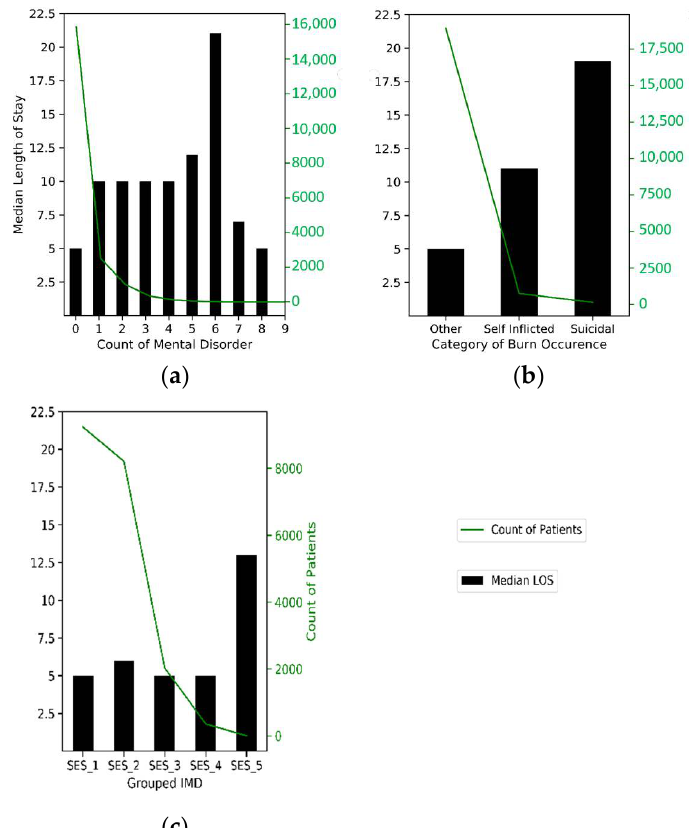
Figure 4. Patient profile by key variables of interest. ( a ) This shows varying median LOS by the number of pre-existing mental disorders. ( b ) This shows varying median LOS by category of burn grouped into two mental states and one other state (nonmental-state-related). ( c ) With deprivation increasing from left to right, this shows varying median LOS by socioeconomic status (SES).